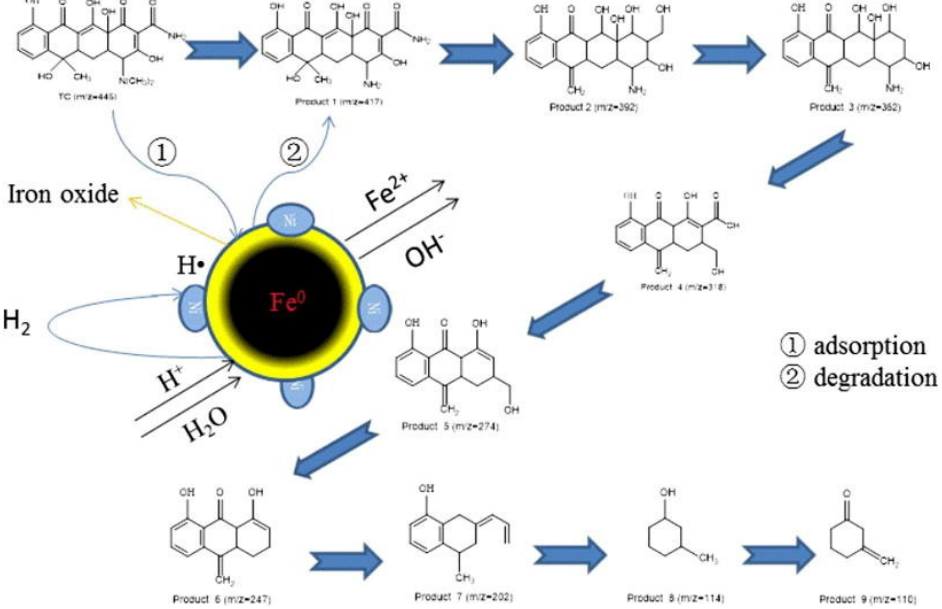
Figure 4. Degradation mechanism of tetracycline in presence of Fe/Ni bimetallic nanoparticles. Reproduced with permission from Dong et al. [89]. Copyright (2018) Elsevier.